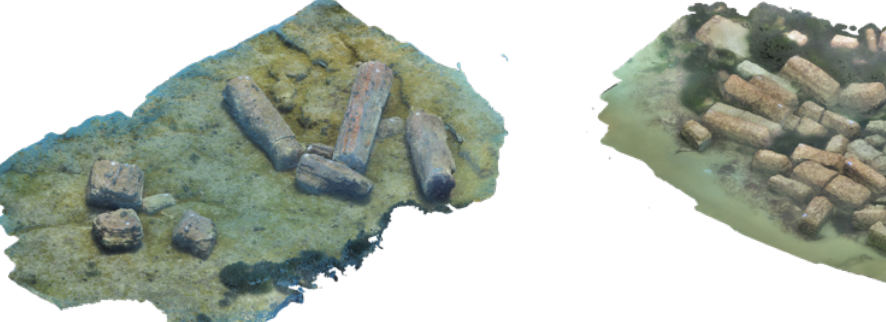
Figure 10. Marzamemi shipwreck. Elaboration with Photoscan. Figure 11. Cape Granitola shipwreck. Elaboration with